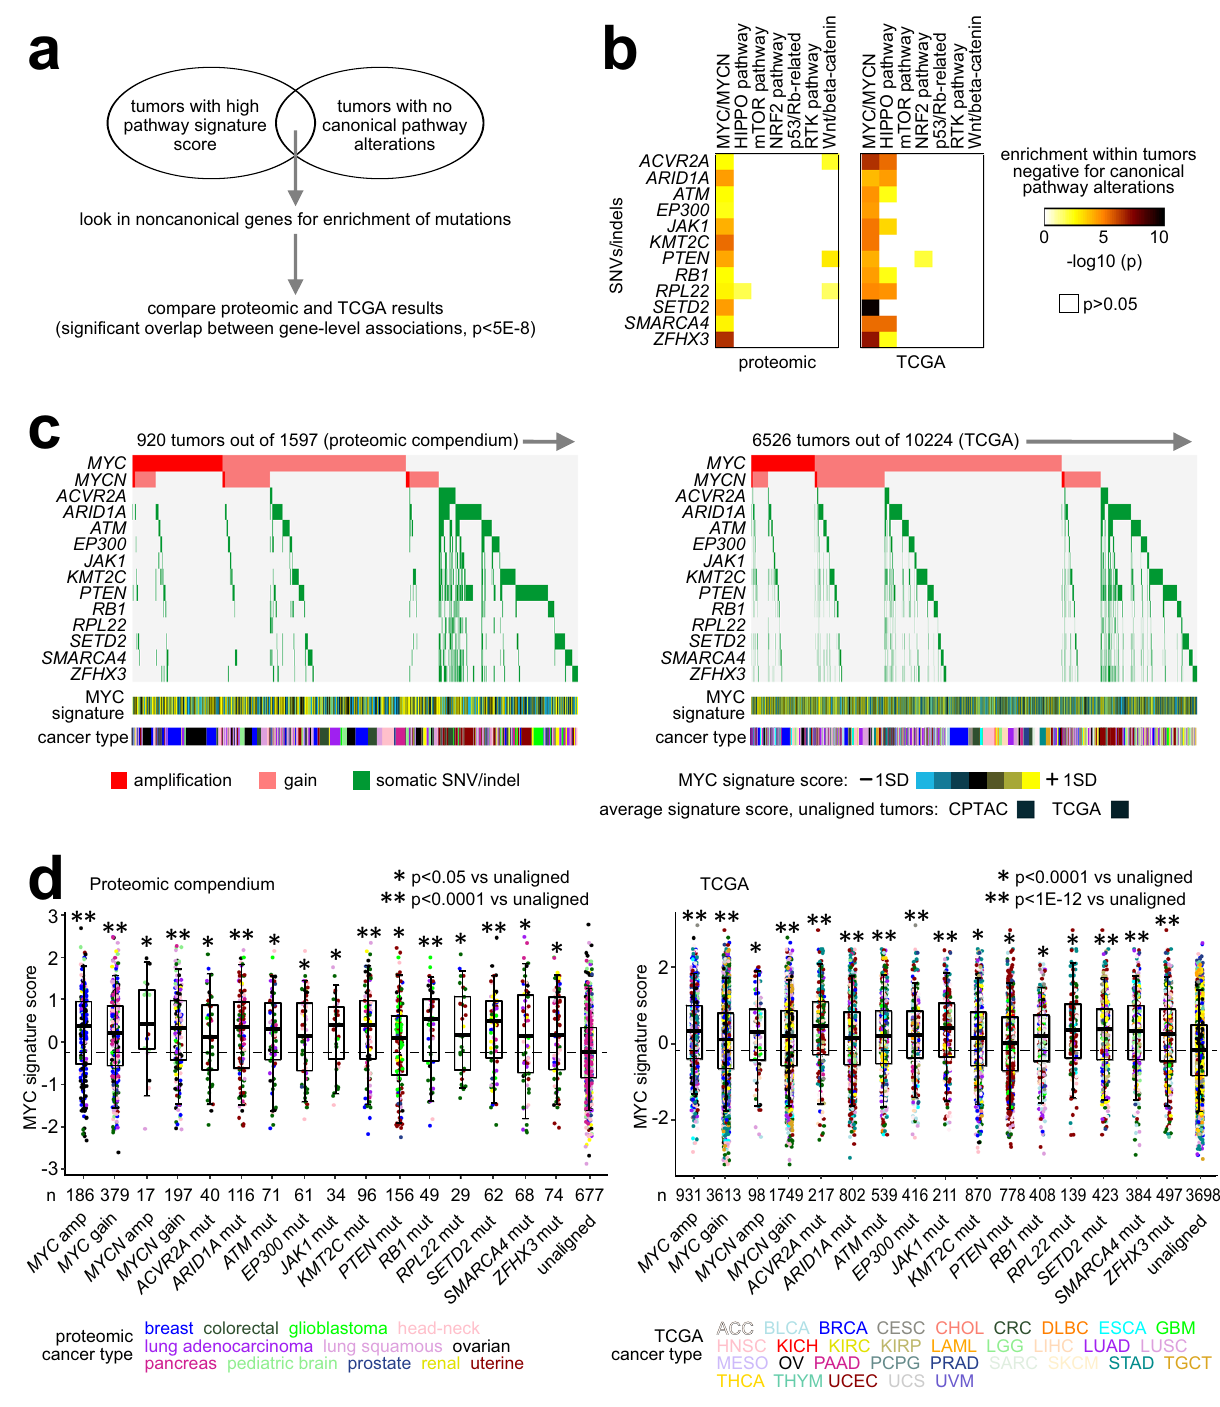
Fig. 10 Noncanonical somatic mutation associations with MYC family alterations. a Schematic of approach to identify somatic mutations (SNVs or indels) associated with a given pathway. Taking the set of tumors with high pathway signature scoring but with no canonical mutations (based on Fig. 7), we consider noncanonical genes for enrichment of mutations. Results are compared between the proteomic compendium and The Cancer Genome Atlas (TCGA), where we observed signi fi cant overlap between the respective gene-level associations ( p < 5E − 8, one-sided Fisher ’ s exact test). b List of top mutated genes overlapping between proteomic compendium and TCGA results ( p < 0.01 and p < 0.001, respectively, one-sided Fisher ’ s exact test). Results involve 12 genes with mutation events enriched within tumors with high MYC signature but no MYC or MYCN copy gain or ampli fi cation. c Across both the proteomic compendium (left) and TCGA (right) tumor datasets, heat maps of MYC/MYCN copy alteration and of somatic mutation (SNV or indel) in genes from b . SD standard deviation from the median. Cancer type color bar legend de fi ned in d . d Box plots of MYC/MYCN signature scores by alteration class in proteomic compendium (left) and TCGA (right) tumor datasets. p values versus unaligned group (tumors with none of the listed alterations) by t - test. Box plots represent 5% (lower whisker), 25% (lower box), 50% (median), 75% (upper box), and 95% (upper whisker). n = biologically independent tumors. Cancer type represents TCGA project